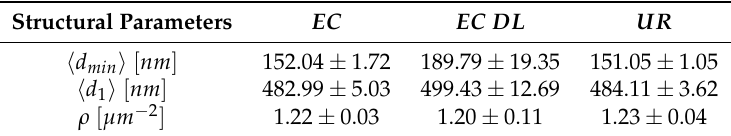
Table 1. Averaged structural parameters of the different analyzed devices. Specifically, d min , d 1 and ρ indicates, respectively, the minimum particle separation, the averaged first-neighbor particle separation, and the particle density evaluated as N / L x L y ( L x , y are the lateral dimension along the x and y